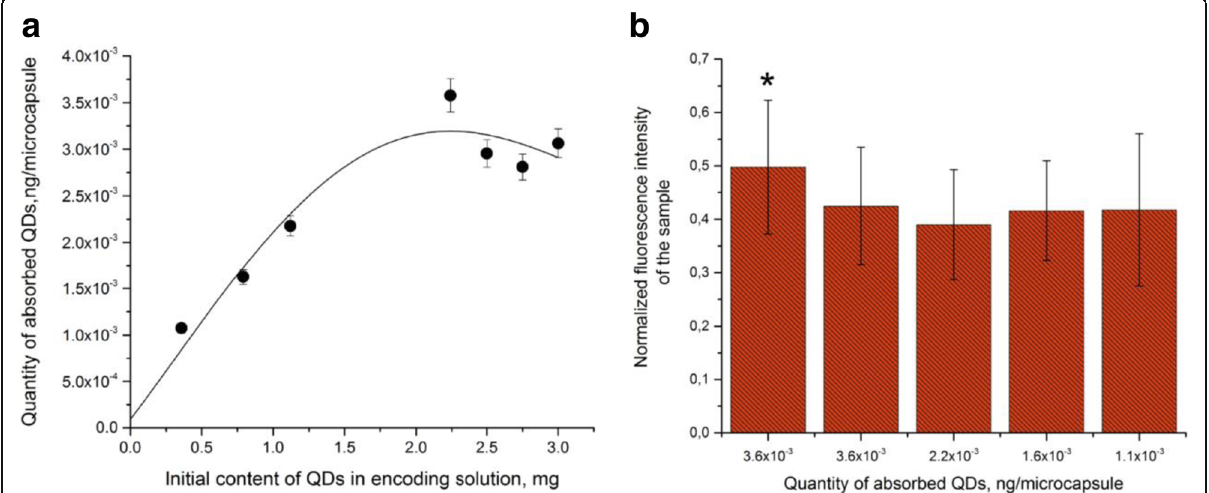
Fig. 7 Estimation of the efficiency of encoding of microparticles with different amounts of quantum dots ( a ) and their fluorescence characteristics ( b ). Asterisk indicates significant difference of QD-encoded microbeads from the QD-encoded microcapsules ( p < 0.05)